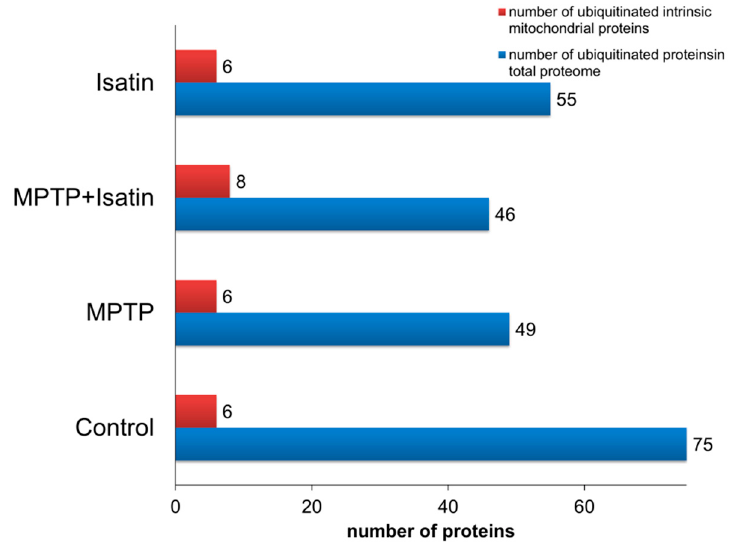
Figure 2. Total number of ubiquitinated proteins identified in the mouse brain mitochondrial fraction.